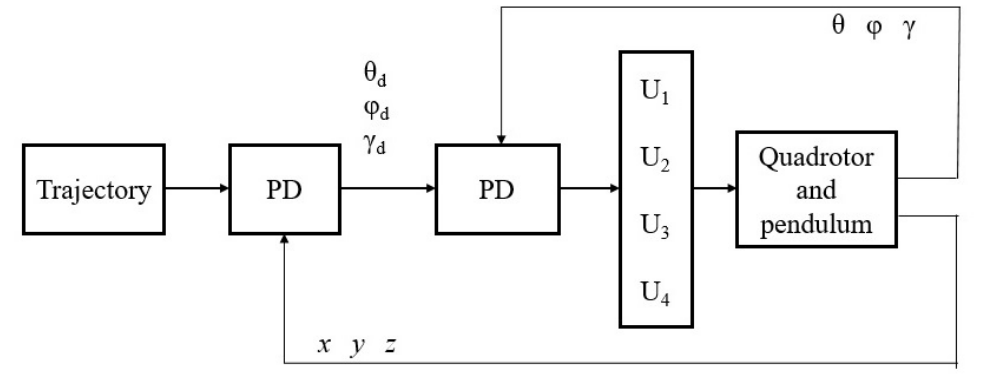
Figure 4. PD-PD control configuration of the